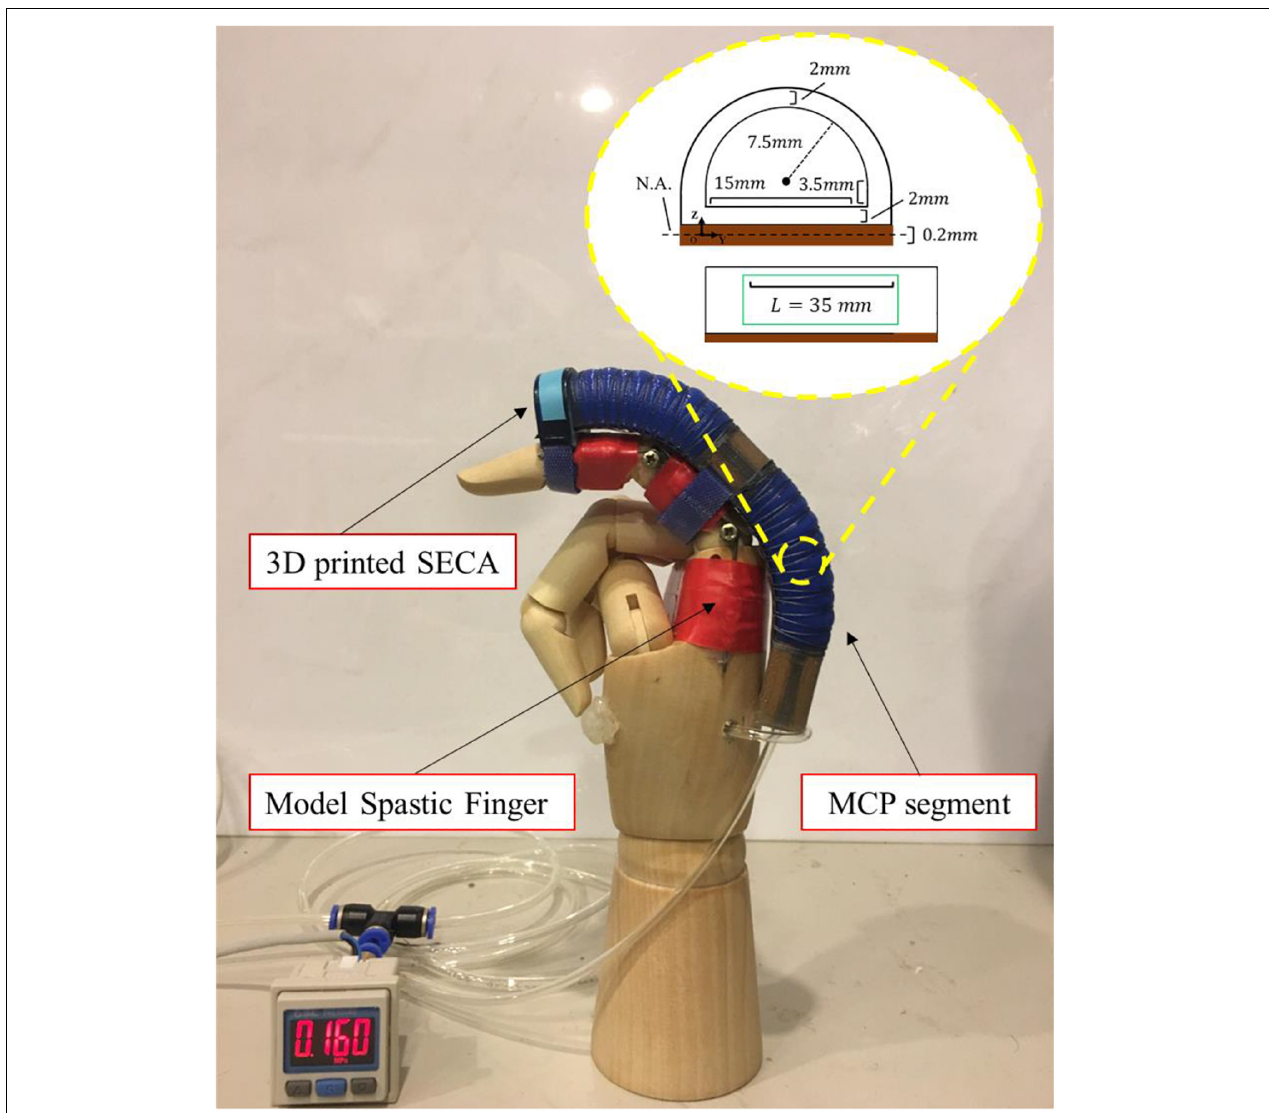
FIGURE 1 | Demonstration of actuated movement of the 3D printed SECA on a model spastic finger. Example actuated state of the MCP joint bound with the MCP segment of the SECA at 160 kPa pressure. Size of the MCP segment is labeled in the